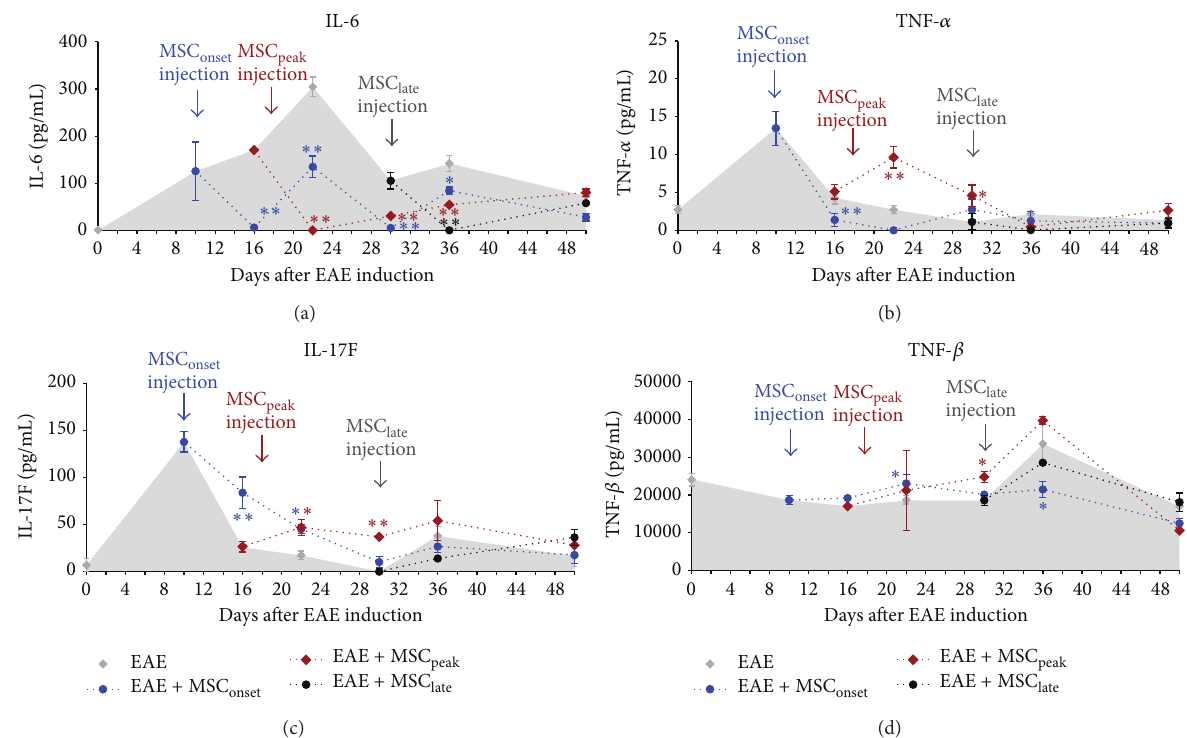
Figure 7: MSCs administration significantly diminished IL-6 plasma levels independently of the time of injection. Plasma samples were ), at the peak isolated from EAE mice, treated or not (EAE) with MSCs at different time of EAE progression, at the onset (EAE + MSC onset ), and at the time of EAE stabilization (EAE + MSC ). Blood samples were taken (day 0), at the onset (day +10), before (EAE + MSC peak late the peak (day +16), after the peak (day +22), at the time of EAE stabilization (day +30), after EAE stabilization (day +36), and at the end of experiment (day +50). Plasma samples were isolated by centrifugation and stored at − 80 ∘ C until being used. Cytokine levels IL-6 (a), TNF- 𝛼 (b), IL-17F (c), and TNF- 𝛽 (d) were detected using Milliplex mouse Th17 magnetic bead panel on Luminex 200 (Merck, Millipore). The samples of each EAE group ( 𝑛 = 7 ) were pooled and analyzed in triplicate. Bars represent the mean ± SEM; statistical differences were calculated using Mann-Whitney test ( ∗ 𝑃 < 0.05